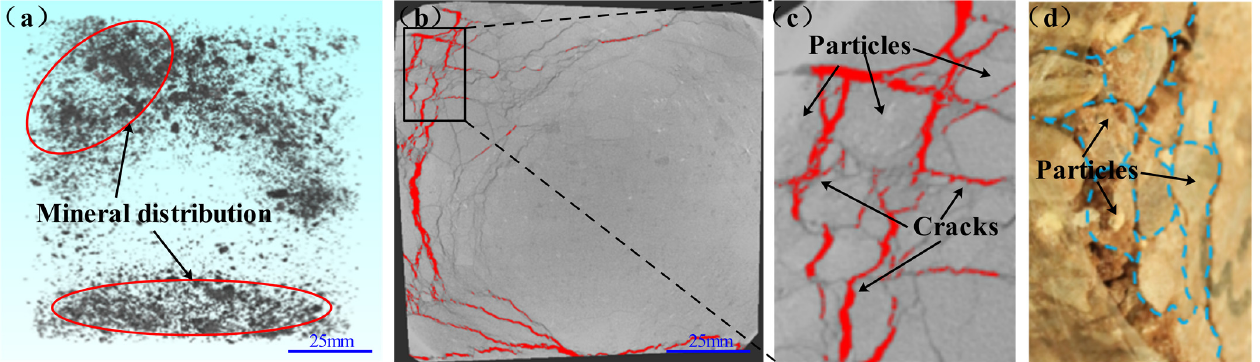
Figure 11. Top view of mineral distribution and fracture. ( a ) Mineral distribution area. ( b ) Part of the fracture network. ( c ) Particles and cracks. ( d ) Particles of real rock. Comparing ( a ) and ( b ), it is obvious to see similarities between the two, the fractures are more complex in the area where min- eral particles are concentrated, and the mineral distribution area is consistent with the distribution of fractures.